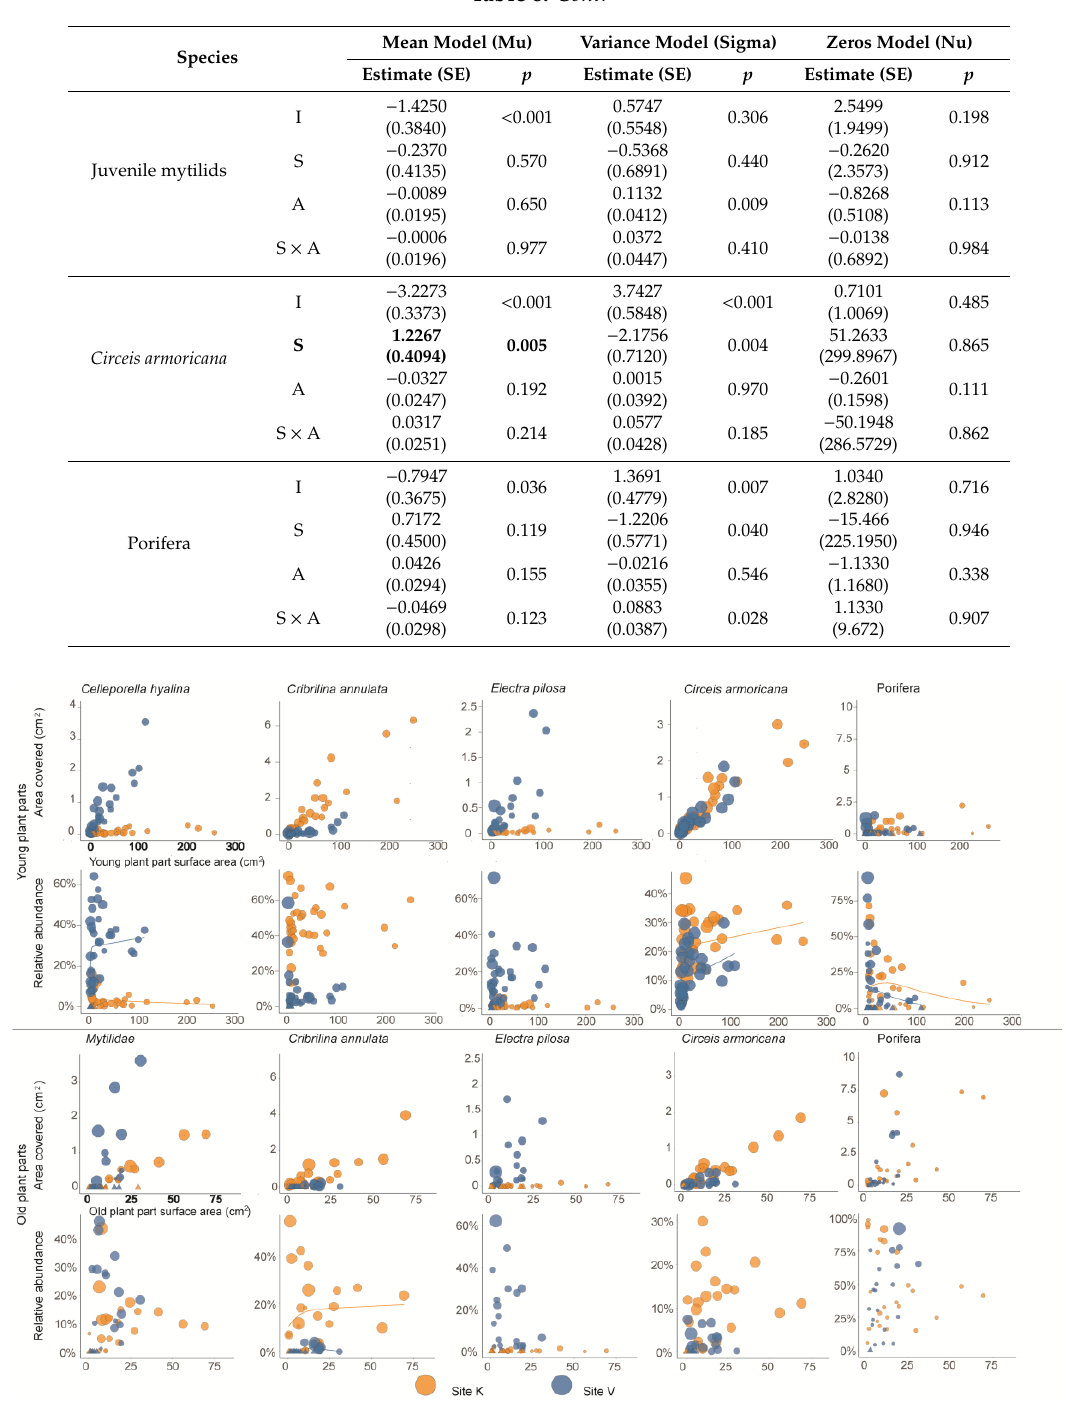
Figure 6. Area covered and relative percent covers of dominant sessile species on young and old parts of Phycodrys rubens by plant part surface area in September 2015. Fit lines plotted where plant part area effect or its interaction with Site were significant (see Table 8 for details on models). Dots mark auxiliary non-randomly sampled 5 largest plants per frame (see Methods for details).